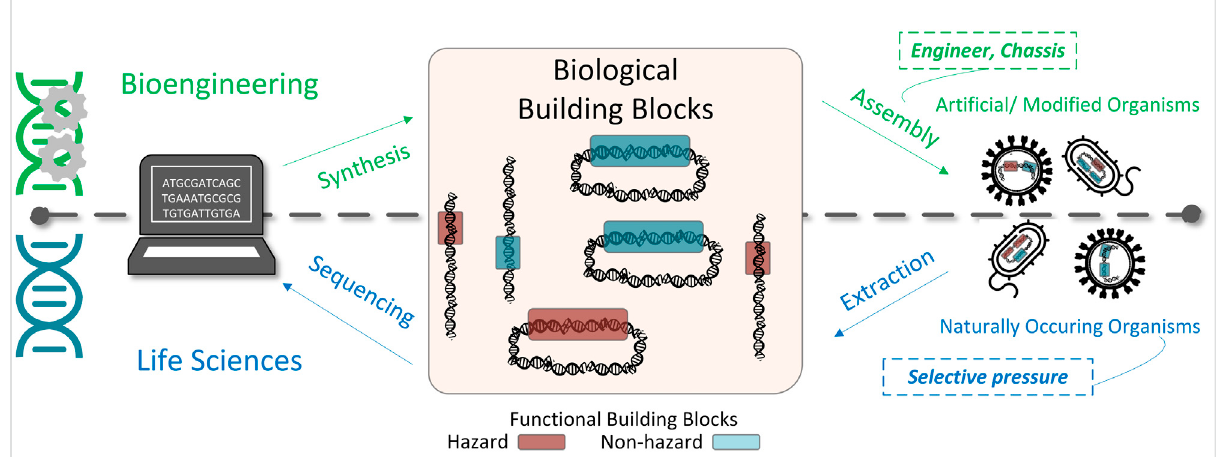
FIGURE 1 Understanding the hazard posed by bioengineering requires the characterization of hazardous building blocks. Bioengineering enables the creation of novel or modi fi ed organisms through oligonucleotide synthesis and assembly of building blocks within a biological vehicle. These biological functional building blocks are inspired from sequences extracted and sequenced from natural organisms. Such organisms can be composed of hazardous and non-hazardous functional elements (denoted by the red and blue blocks, respectively). The hazardous functions within organisms may have arisen from environmental selective pressures such as virus mutation to enable, for example, a jump from a vector to a human host, or a transfer of transposable elements among